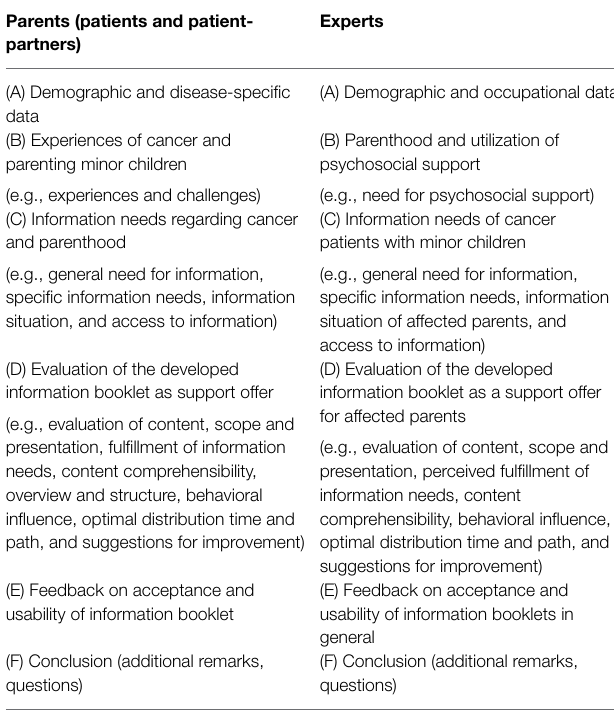
TABLE 1 | Content of semi-structured interview guidelines with experts and affected